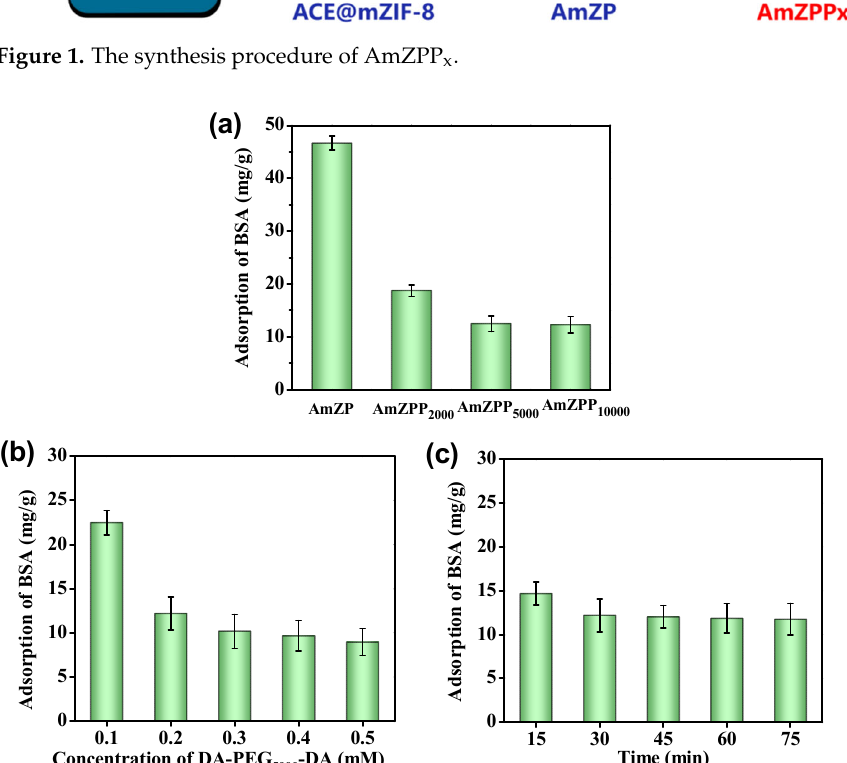
Figure 2. The BSA adsorption performance of AmZPP x with the different polymer length ( a ), concentration of DA-PEG 5000 -DA ( b ) and contact time ( c ).